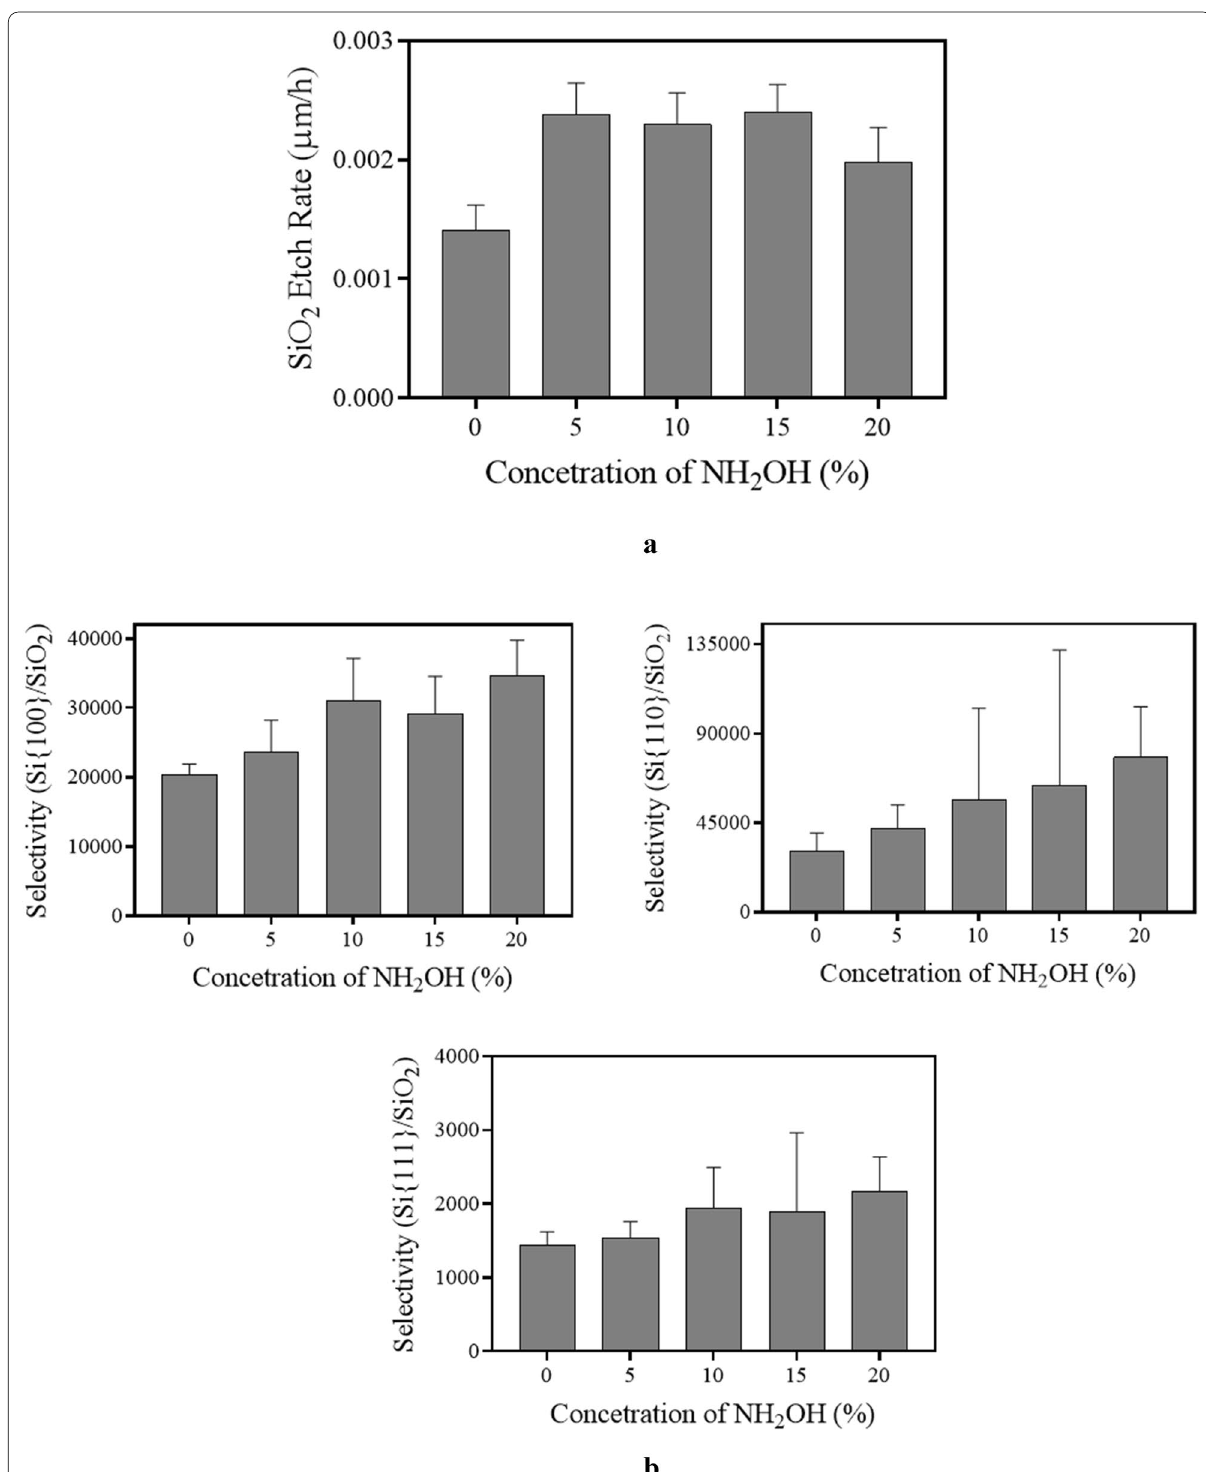
Fig. 32 a Etch rate of silicon dioxide and b the etch selectivity between silicon and silicon dioxide (R Si /R SiO2 ) in 5 wt% TMAH at 70 and with addition of